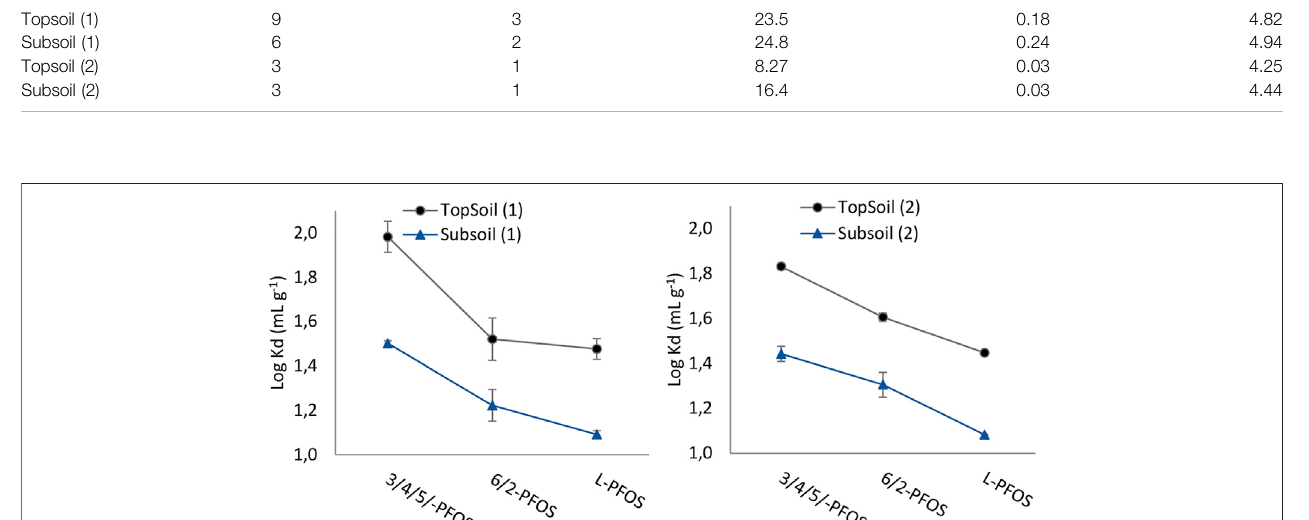
FIGURE1| Logarithmicpartitioningcoef fi cientsforPFOSisomersonsoils.Thedotsrepresent theminimumandmaximumvalues( n =2).ThepHinsolutionswere 5.5 ± 0.4.